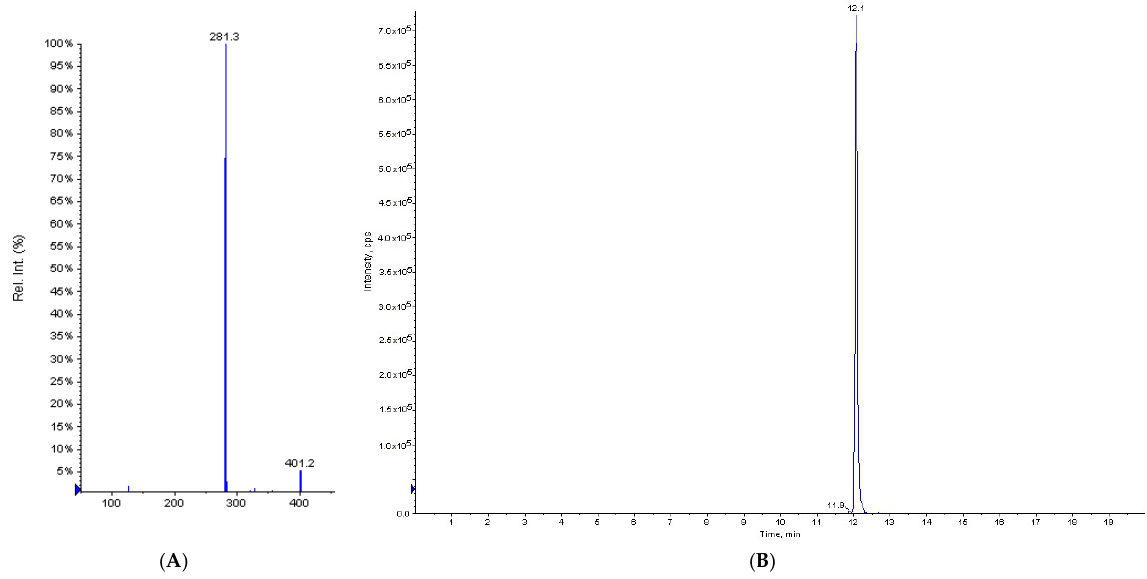
Figure 2. Mass spectrum of TyOle acquired in negative product ion scan (PIS) mode at − 25 eV collision energy ( A ). HPLC- MS/MS chromatogram of TyOle. The multiple reaction monitoring (MRM) transition monitored was 401.2 → 281.3 ( B ).